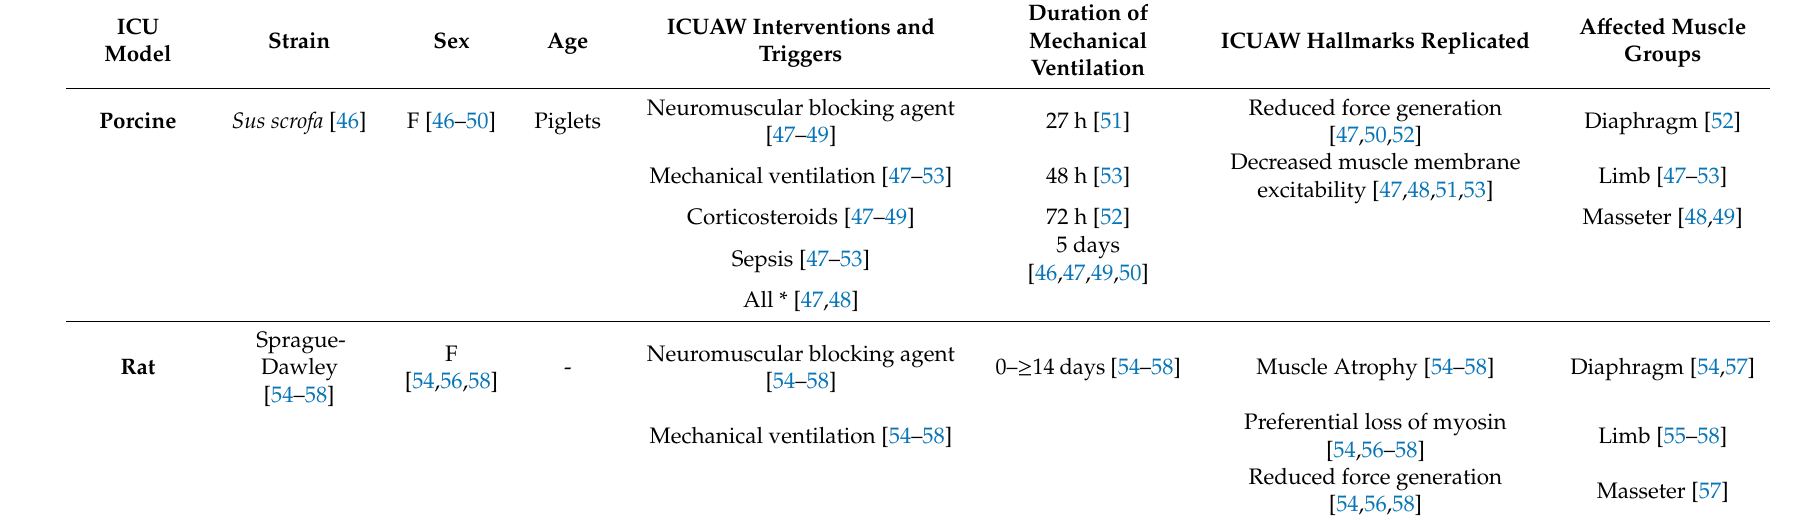
Table 1. Summary of Existing Intensive Care Unit Animal Models and Their Key